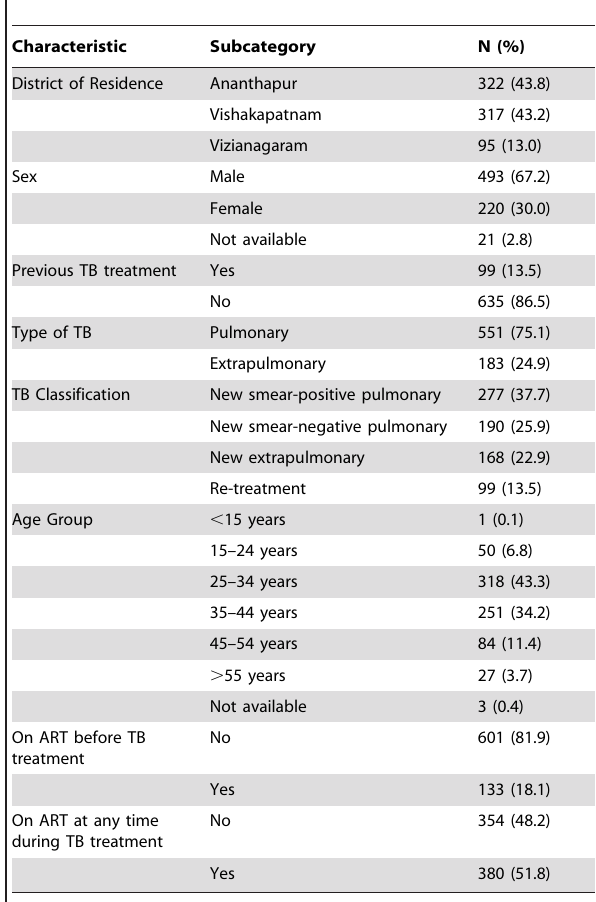
Table 1. Characteristics of HIV-infected TB patients, Andhra Pradesh, India, 2007 (N